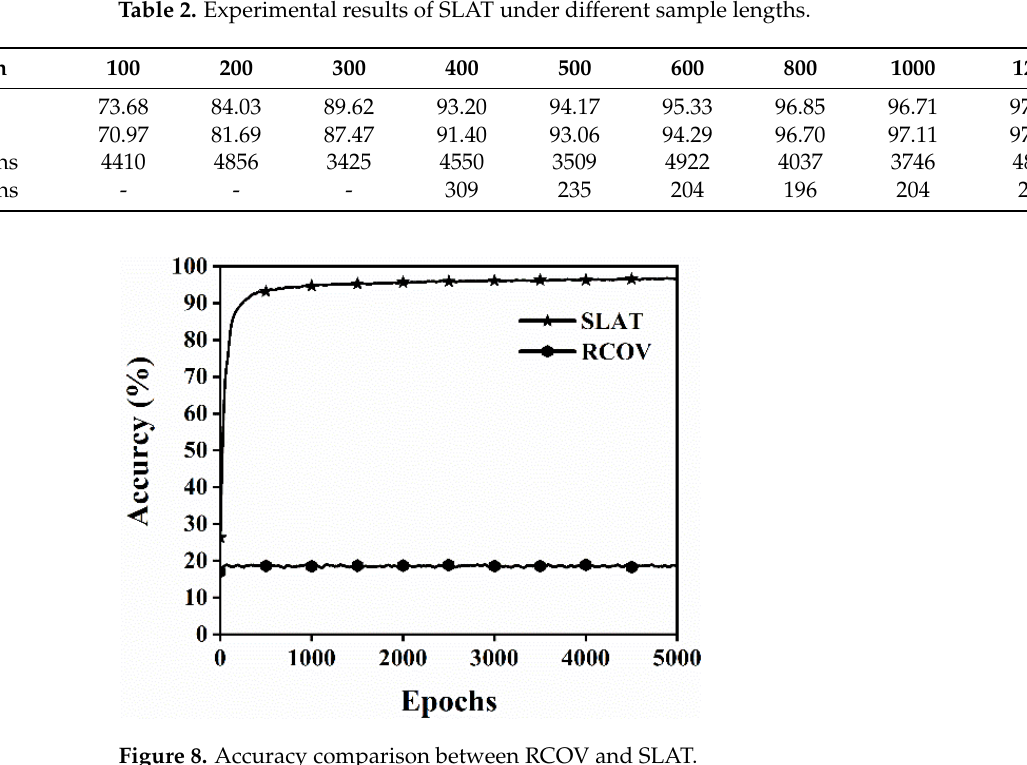
Table 3. Experimental results of MLAT under different sample